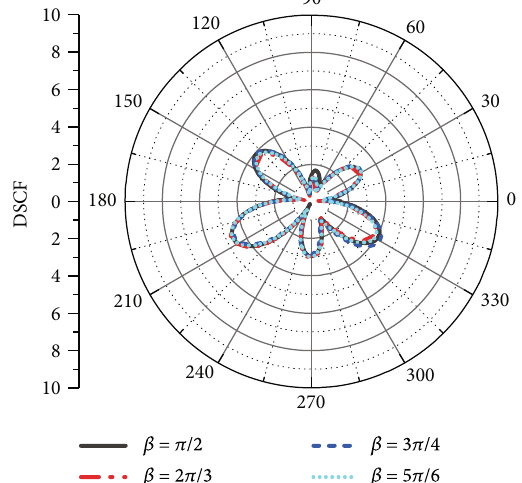
Figure 9: DSCF distribution of the circular hole for di ff erent values of β ( α 0 = 60 ° ).